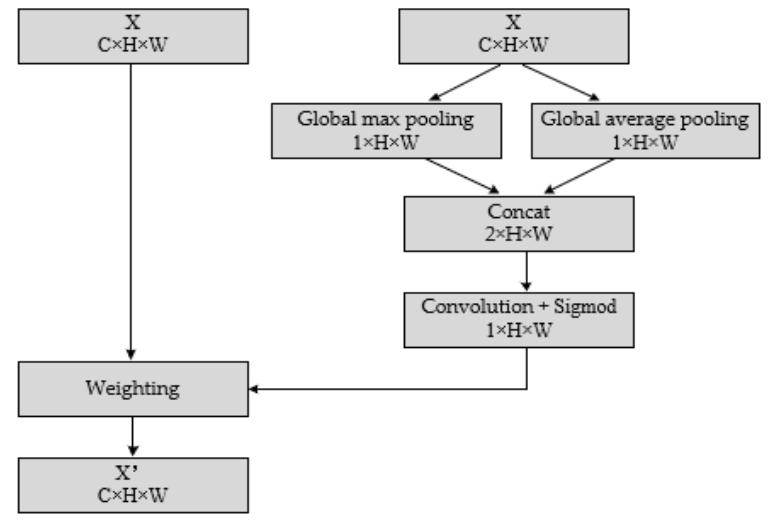
Figure 5. Spatial attention module structure.